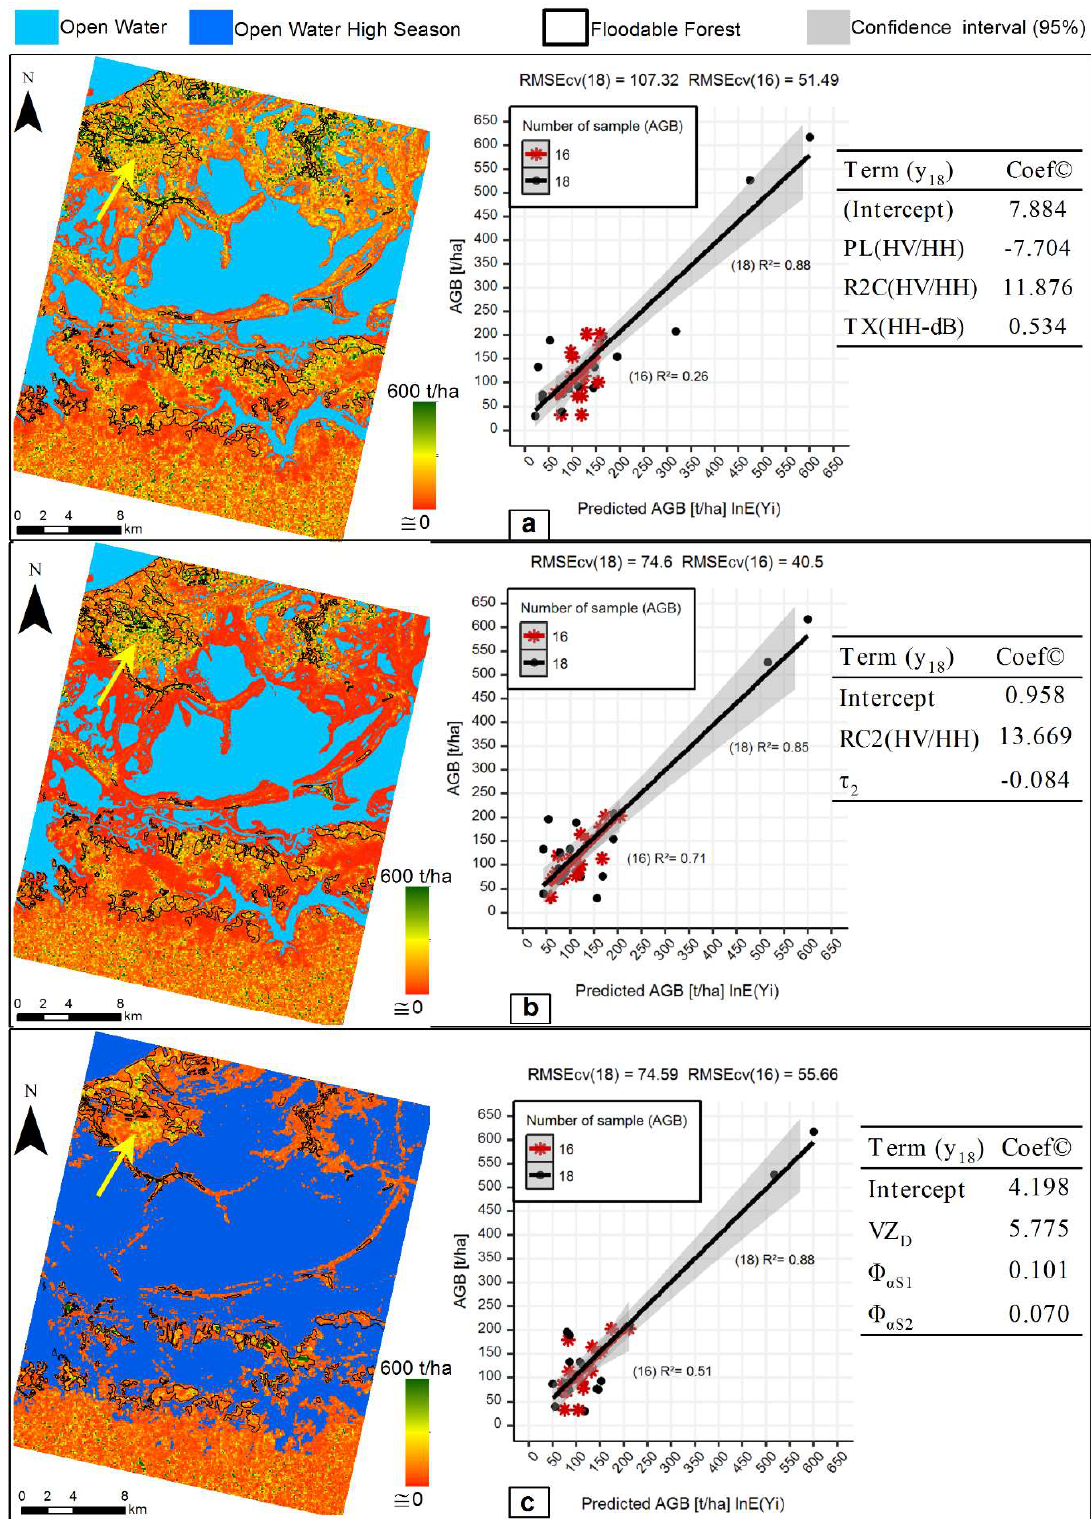
Figure 8. Comparison of predicted and observed values of AGB and spatial prediction for the models: ( a ) MULT 18 , ( b ) RC2(POL) 18 , and ( c ) PL-PLR(POL) 18 . The yellow arrow indicates some high-density shrub areas. Central Amazon floodplain, Brazil.